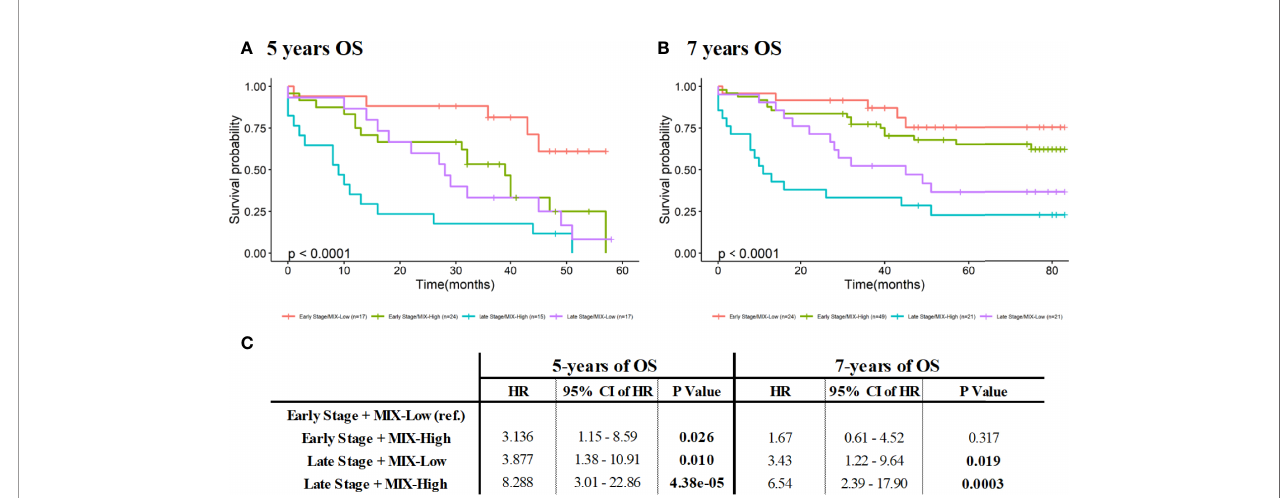
FIGURE 4 | Combination of pTNM staging and MIX scoring for survival analysis at 5- and 7 years (60 and 84 months respectively). Comparison of survival curves was performed using Kaplan-Meier method (with log-rank test) by strati fi cation of patients according to early and late stages or Low- and High-MIX scoring, at 5- (A) and 7- (B) years. (C) Prognostic values of pTNM staging and MIX scoring for survival analysis at 5- and 7 years of patients ’ follow-ups were analyzed. Resulting HR (with 95% CI) for stratifying patients for 5- (left) and 7- (right) years of OS using stage and MIX scoring combination, were obtained by univariate Cox modeling. CI, Con fi dence Interval; HR, Hazard Ratio; OS, Overall Survival; pTNM, pathology Tumor Node Metastasis